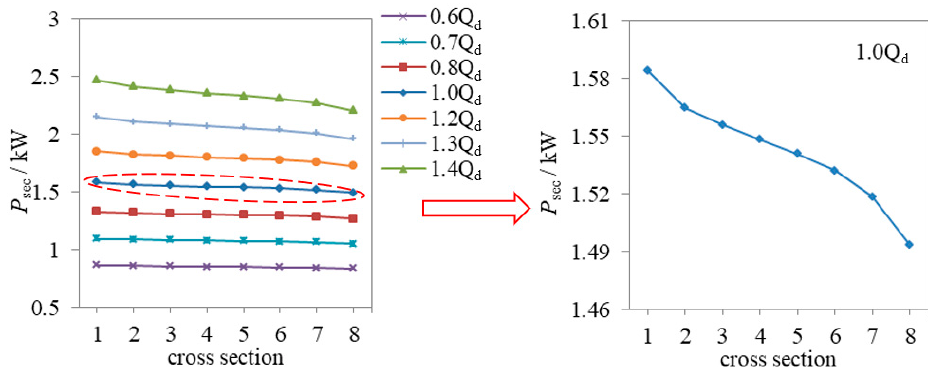
Figure 8. Power for each cross-section of the runner.